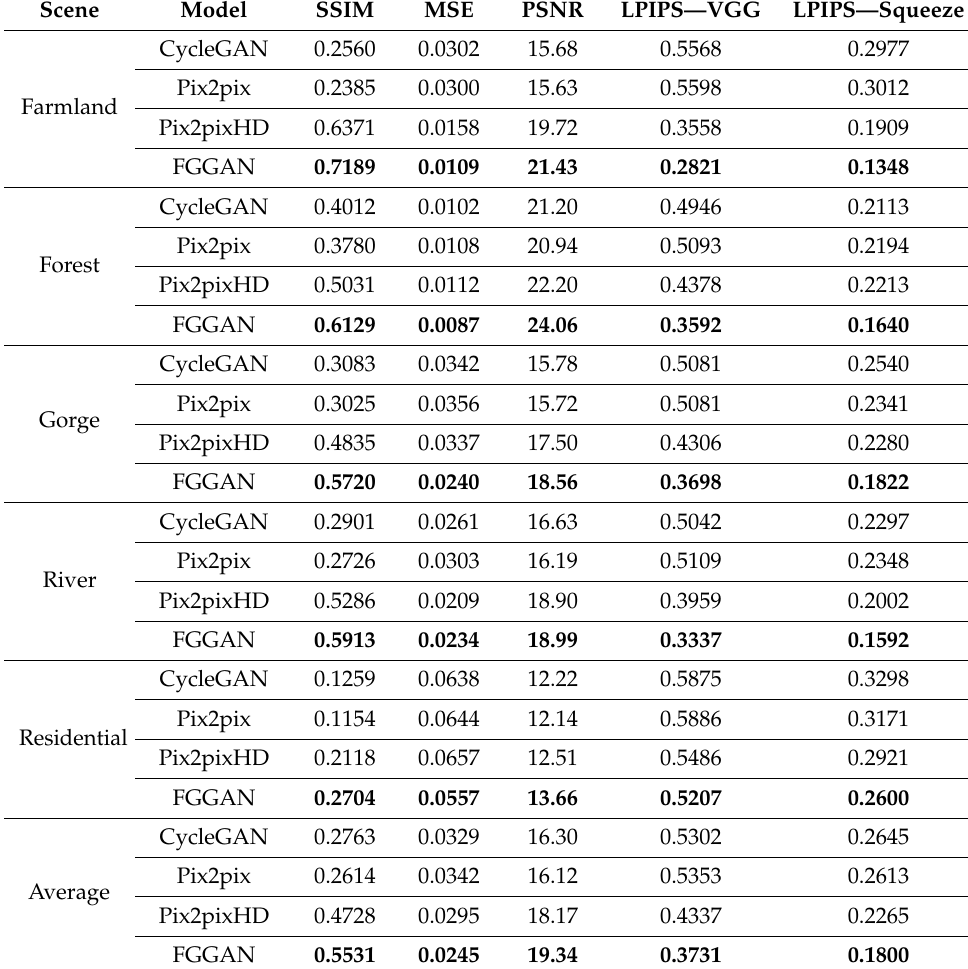
Table 4. Objective evaluation of the images generated by the translation models. LPIPS adopts the linear structure. Bold in the table represents the best result using the